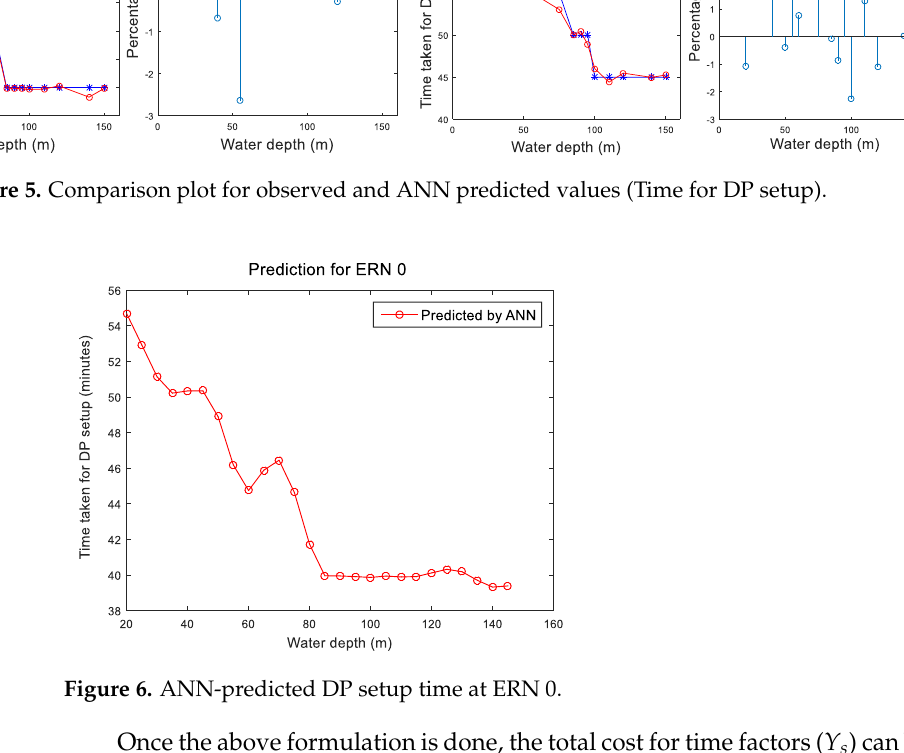
Figure 5. Comparison plot for observed and ANN predicted values (Time for DP setup).